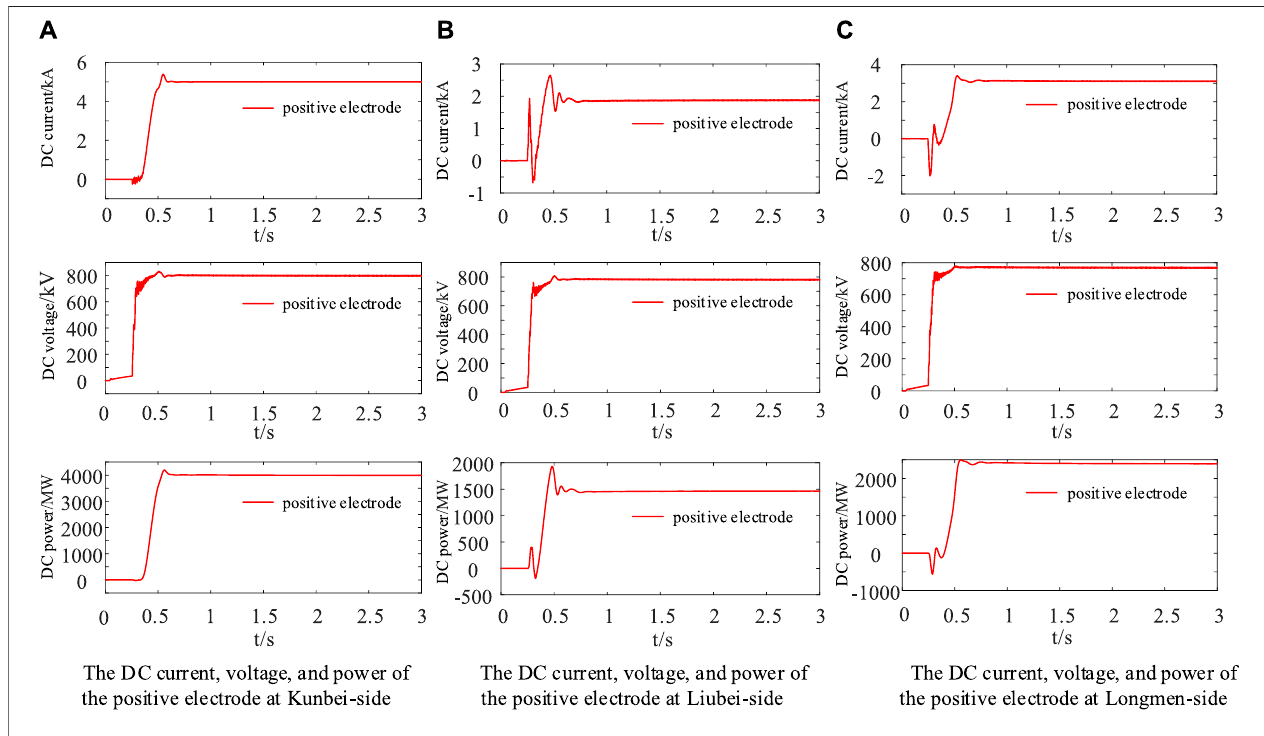
FIGURE 9 | Simulated waveform of positive full voltage ground return